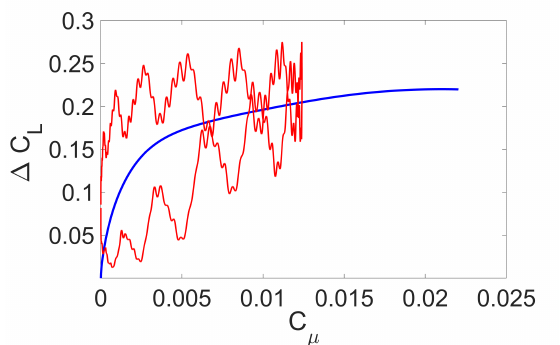
Figure 3. Lift response to static (blue) and dynamic (red)